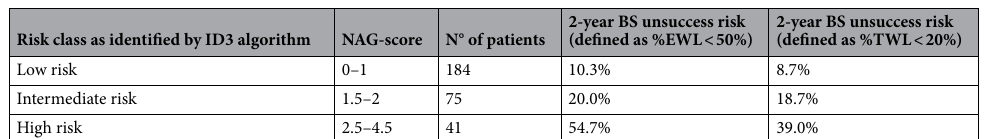
Table 3. Pre-surgical estimation of unsuccessful weight loss at 2-years from BS according to NAG-score risk classes. BS bariatric surgery, EWL excess weight loss, ID3 Iterative Dichotomiser 3, TWL total weight loss.